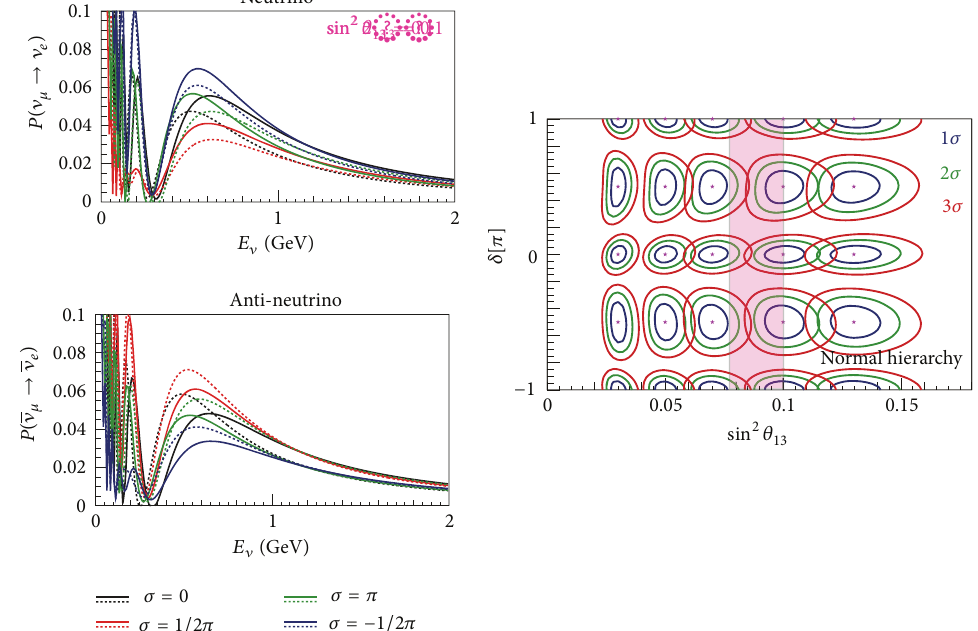
Figure16:Transitionprobabilityofmuonneutrinotoelectronneutrinoatthedistanceof295 kmforneutrino(lefttoppanel)andantineutrino values. Solid and dashed lines represent normal and inverted mass (right top). Each color shows the appearance probability for each 𝛿 CP hierarchy, respectively. The right panel shows expected contours for each true (𝛿, sin 2 2𝜃 13 ) parameter set by 7.5MW ⋅ years JPARC-HK long- baseline neutrino oscillation experiment. Three colors show 1, 2, and 3 𝜎 significance. The pink band corresponds to the 𝜃 13 value measured by the Daya Bay reactor experiment